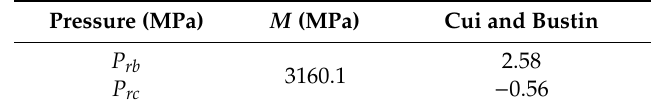
Table 10. The rebound pressure P rb and recovery pressure P rc values for the Cui and Bustin model, as obtained for the coal from the San Juan-Northeast of Fairway basin. 380